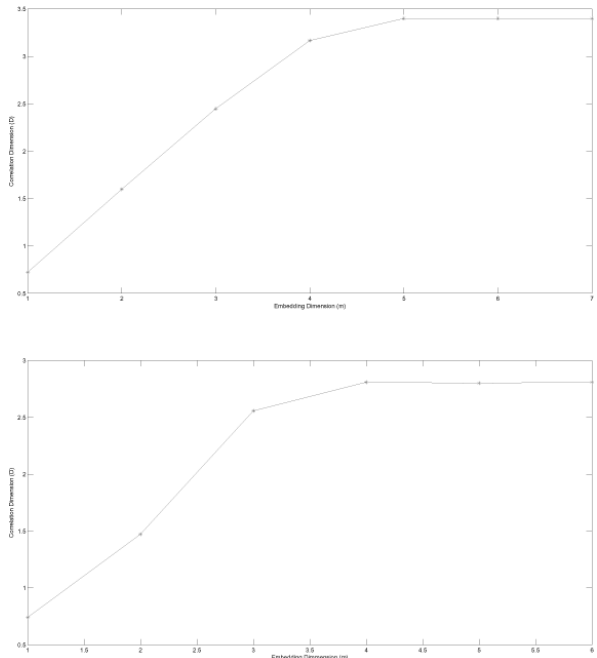
Fig. 7. Correlation dimension for (upper panel) the quietest day of October 2011 for TEC measured at Lagos that saturates at τ = 30, and m ≥ 5 (lower panel) the most disturbed day of October 2011 for TEC measured at Lagos that saturates at τ = 32, and m ≥